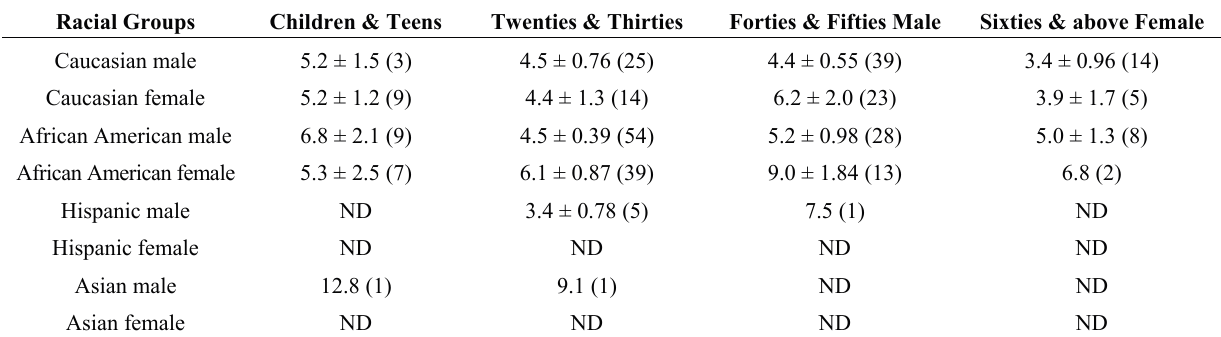
Table 1. Concentrations (ng/mL) of Σ PAH residues in serum samples from autopsy